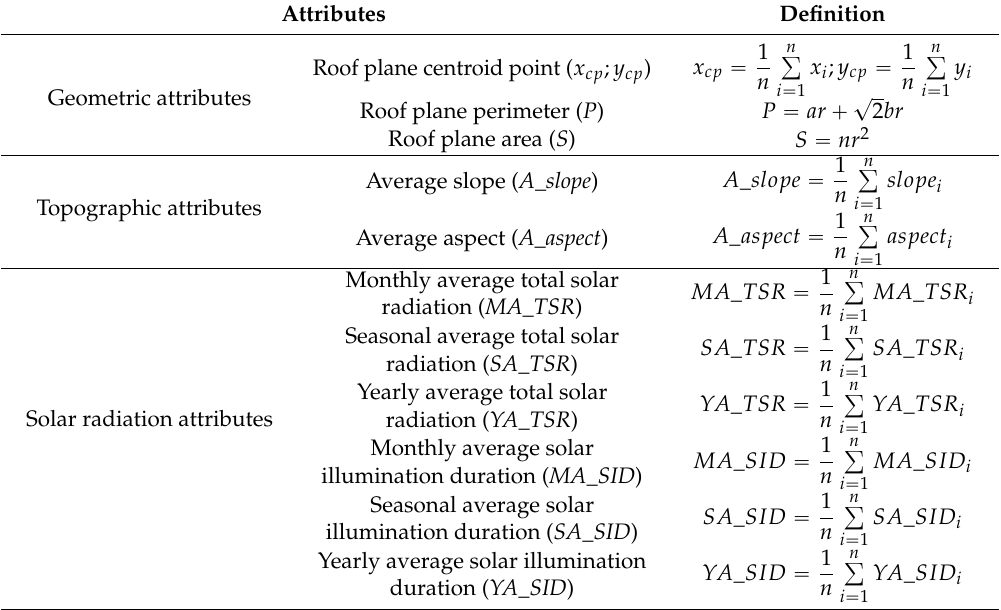
Table 1. Definition of geometric, topographic, and solar radiation attributes of roof